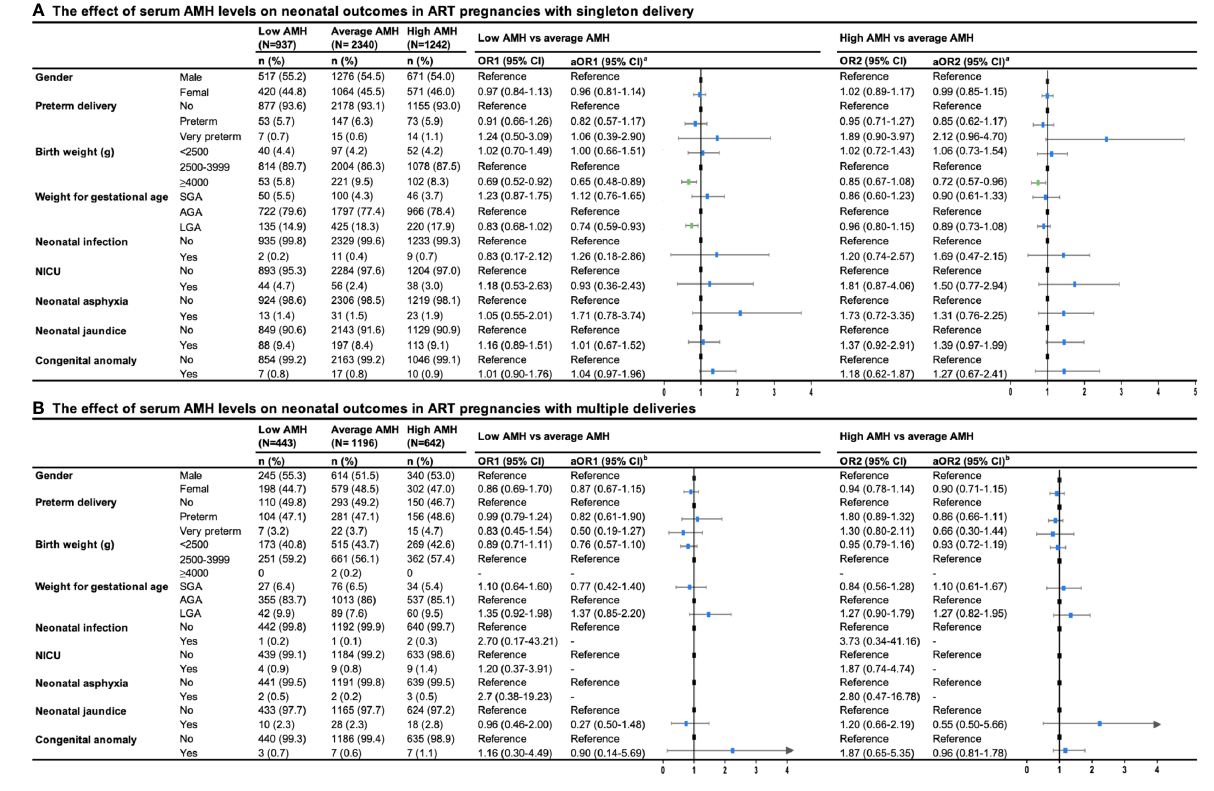
FIGURE 3 Forest plot summary of logistic regression analysis for risks of neonatal outcomes in ART pregnancies with (A) singleton and (B) multiple deliveries. OR, odds ration; CI, con fi dence interval; aOR, adjusted odds ration; SGA, small for gestational age; AGA, appropriate for gestational age; NICU, neonatal care unit. aaOR was adjusted for maternal age, paternal age, race, residence, gravidity, parity, duration of infertility, primary infertility, causes of infertility, study center, controlled ovarian stimulation protocol, type of insemination, transfer cycle types, embryo types, number of embryos transferred. baOR was adjusted maternal age, paternal age, residence, gravidity, parity, primary infertility, causes of infertility, study center, controlled ovarian stimulation protocol, type of insemination, transfer cycle types, embryo